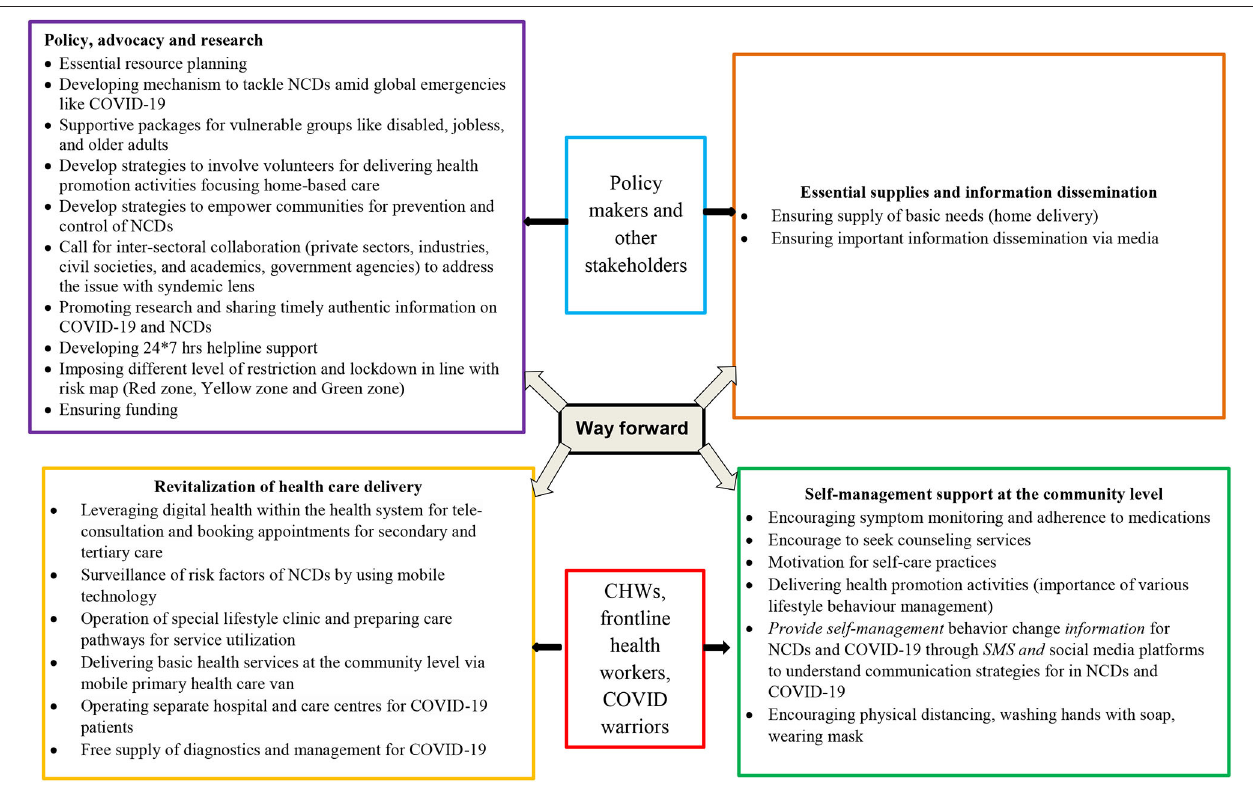
FIGURE 2 | Strategies to overcome and manage the syndemic